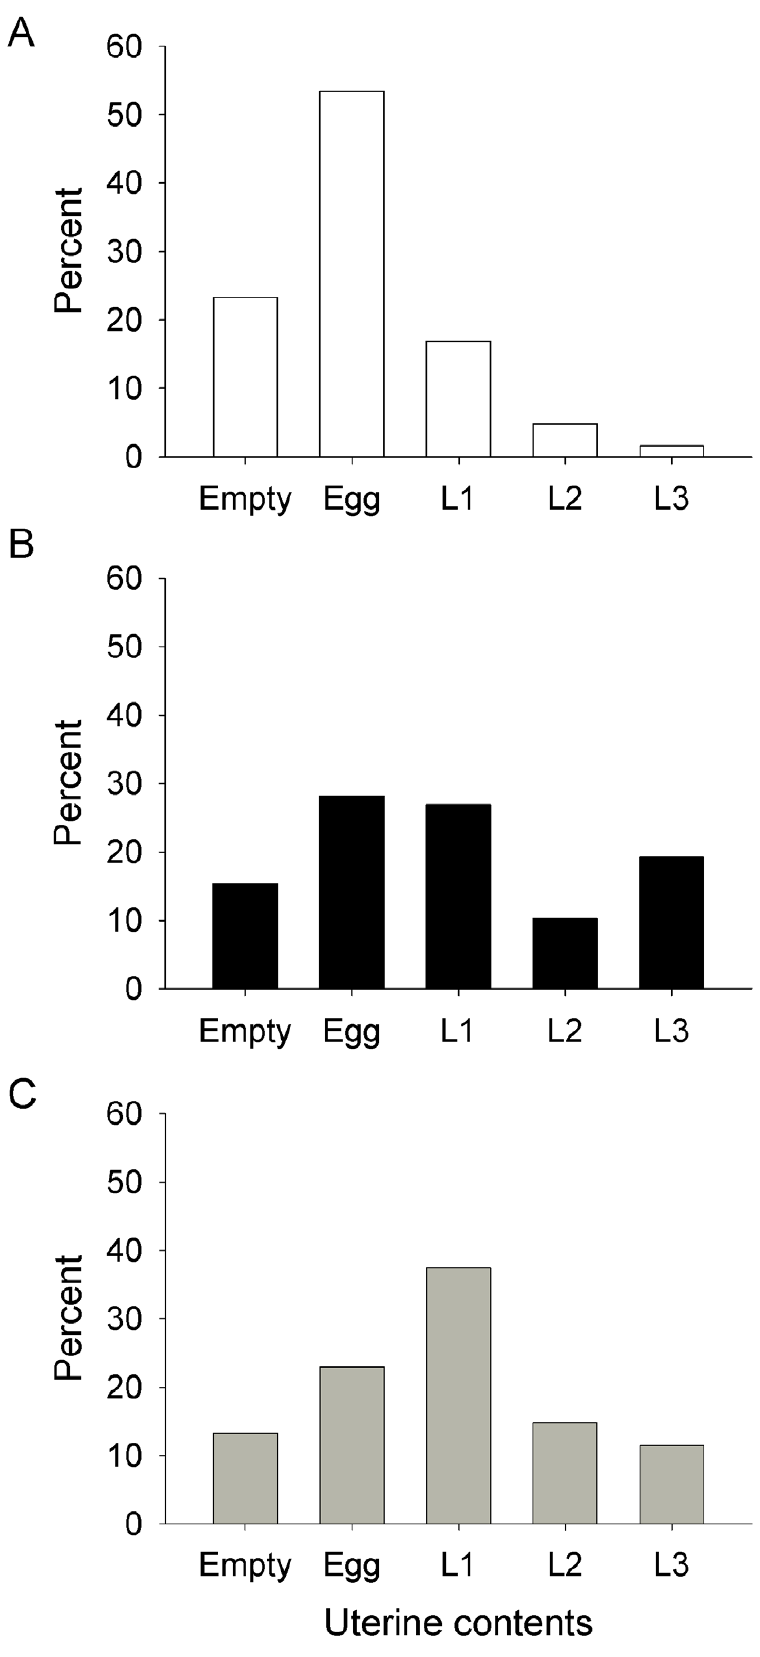
Figure 3. Uterine contents of female G.m.morsitans from (A) men, (B) ox and (C) traps. Percent distribution of uterine contents of female G. m. morsitans in ovarian categories . 0, from (A) men, (B) ox and (C) traps. Sample sizes of 189, 78 and 270 for men, ox and traps, respectively. doi:10.1371/journal.pntd.0001791.g003 PLOS Neglected Tropical Diseases |